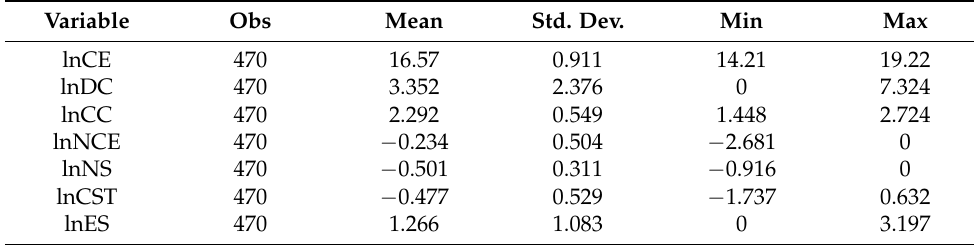
Table 1. Descriptive statistical results of each